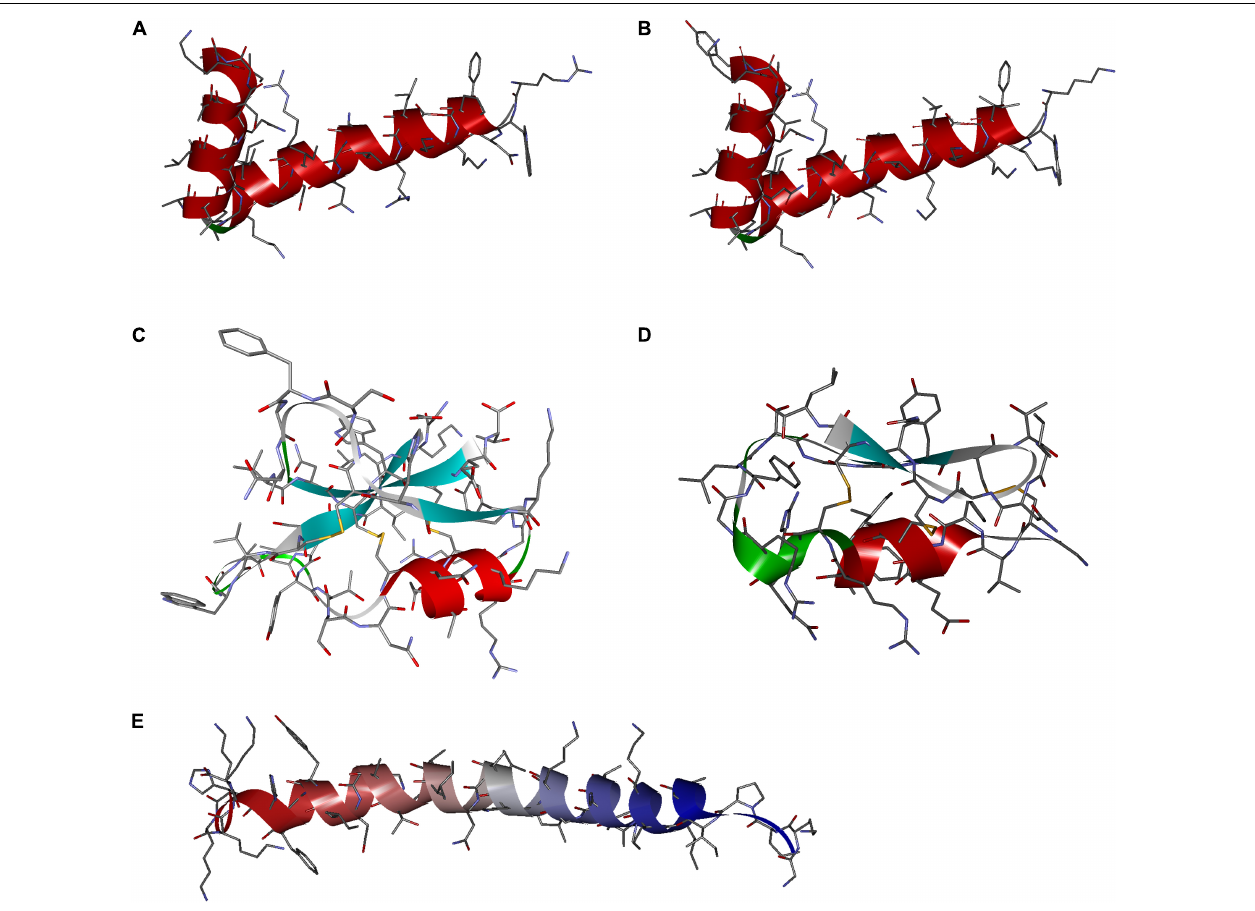
FIGURE 3 | Secondary structures of the designed peptide. The three-dimensional shapes of the synthetic molecules, e.g., (A) cecropin A, (B) cecropin B, (C) denfensin A, (D) denfensin B, and (E) moricin A, were constructed by homology modeling, which demonstrated typical structural features of respective classes of antimicrobial peptides (AMPs). TABLE 3 | In vitro antimicrobial activities of the designed peptides. AMPs Escherichia coli Staphylococcus aureus Candida